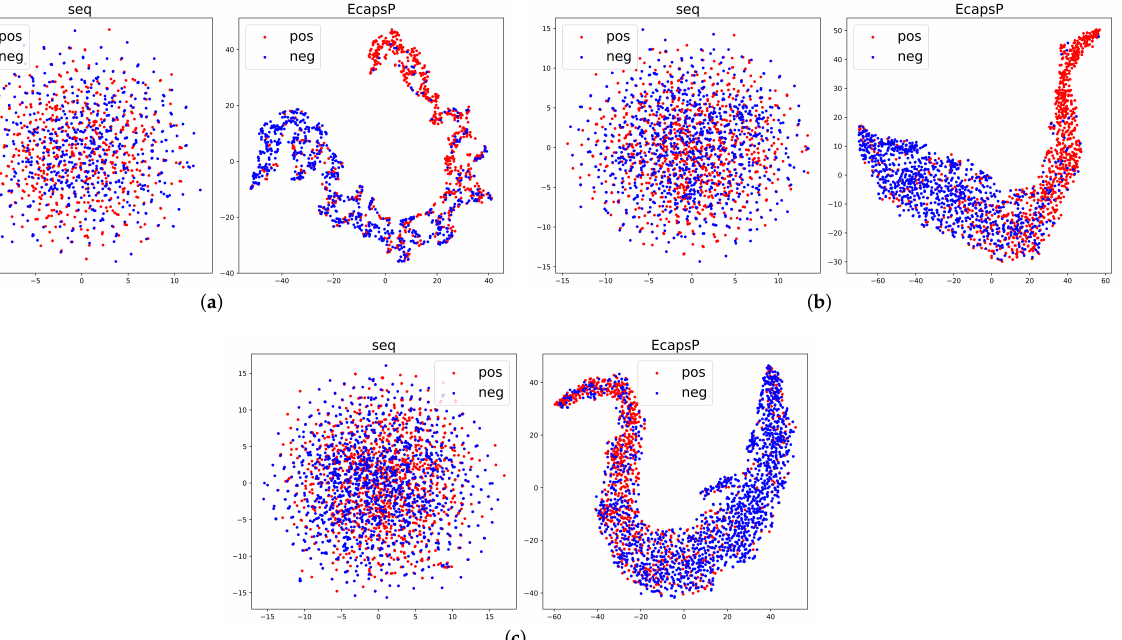
Figure 4. Visualization of the original sequence features and sequence features extracted by EcapsP. ( a ) Tyrosine phosphorylation. ( b ) Threonine phosphorylation. ( c ) Serine phosphorylation. The red point represents the phosphorylation samples while the blue point represents the unphosphorylation